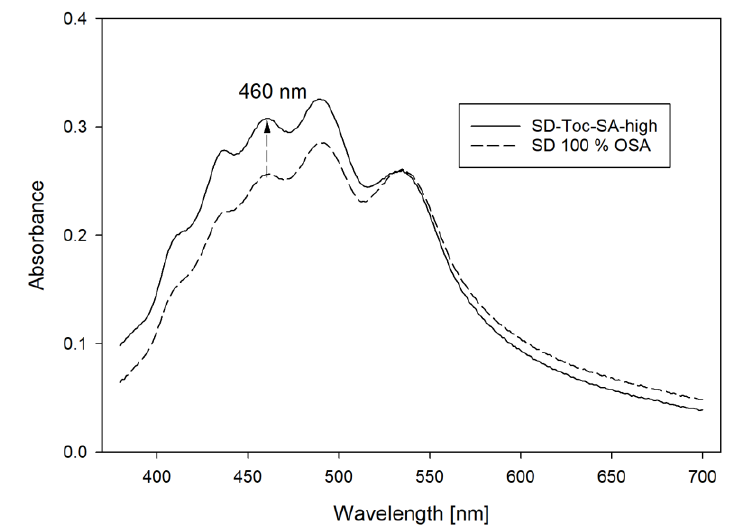
Figure 7. Variation in UV/Vis spectra of spray dried carrot carotenoids formulated with antioxidants (mixed tocopherols and sodium ascorbate) and maltodextrin as carrier material (SD-Toc-SA-high) and no antioxidants and octenyl succinic anhydride-modified starch as carrier material (SD 100% OSA) after storage (35 °C, 91 days, air).